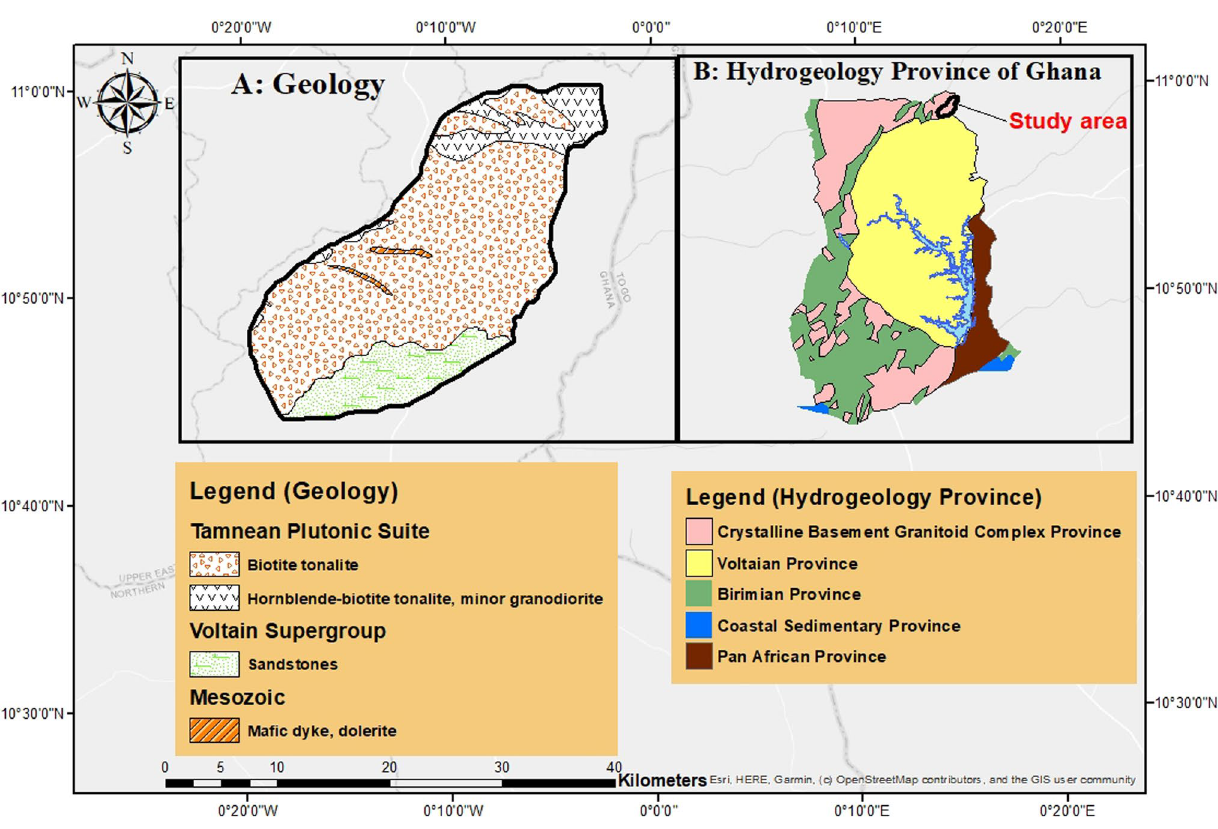
Fig. 2 a The geological map of the area b the hydrogeology provinces of Ghana after Banoeng-Yakubu et al.